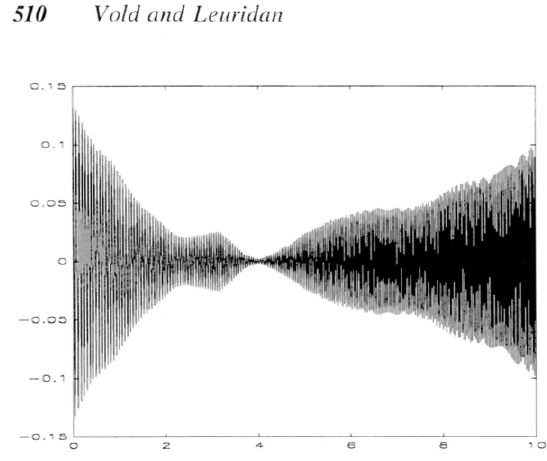
FIGURE 1 Waveform prediction error with Gauss ian noise.